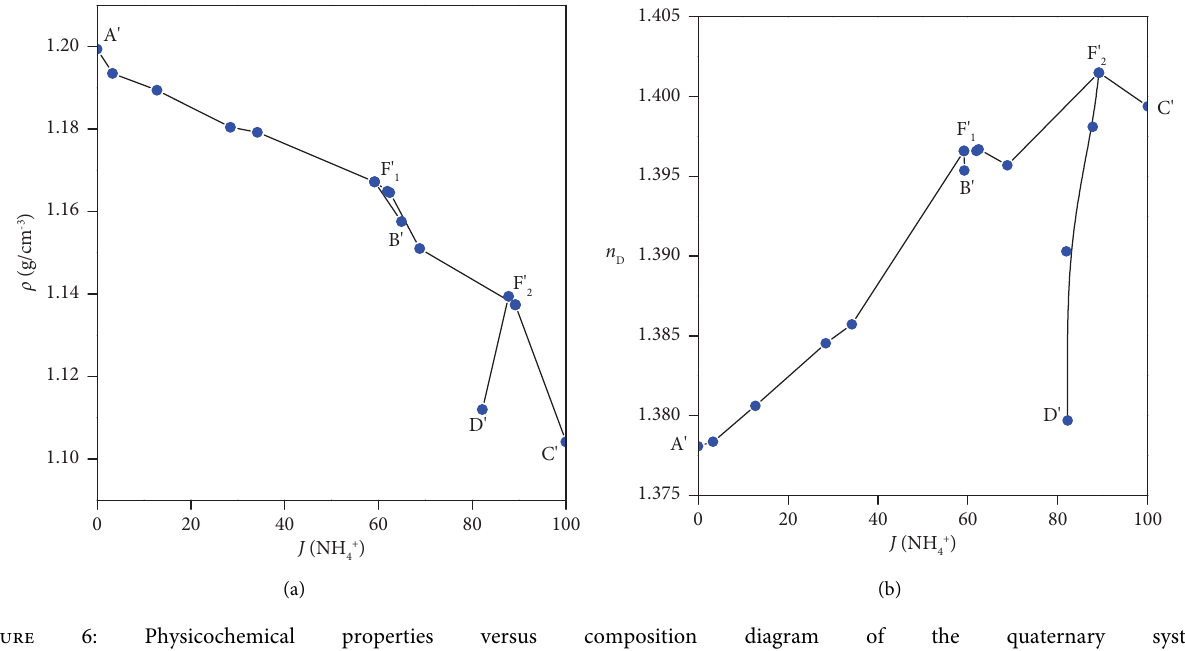
6: Physicochemical properties versus composition diagram of the quaternary